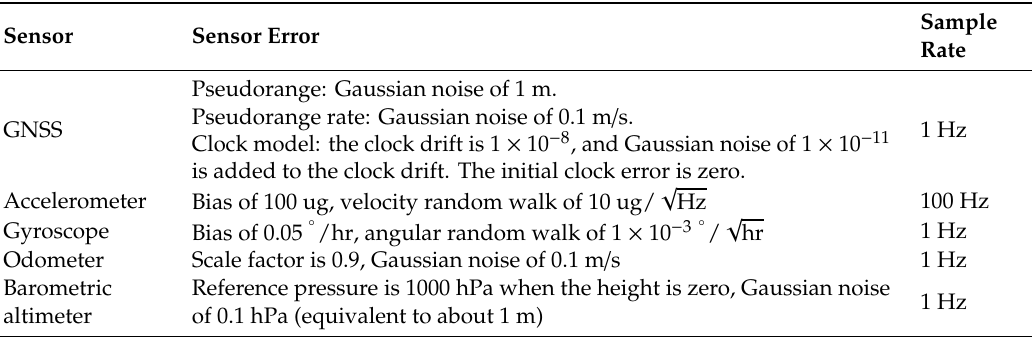
Table 2. List of sensor simulation parameters.